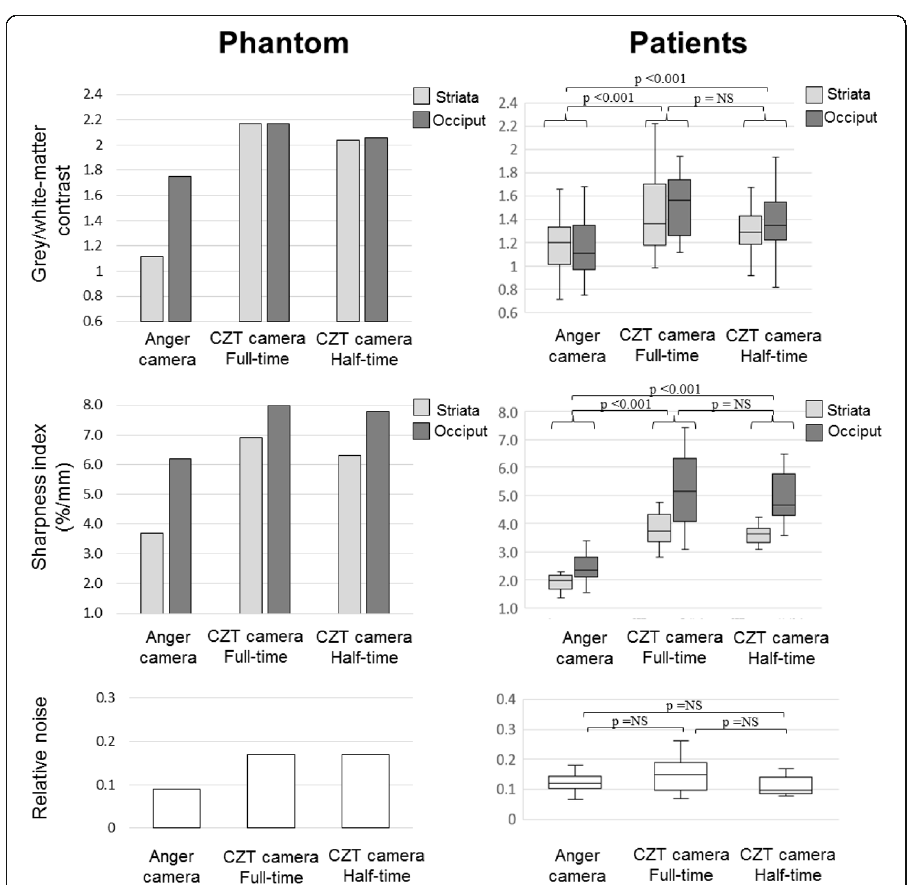
Fig. 2 Grey/white matter contrast (upper panel), spatial resolution assessed through a sharpness index (middle panel), and relative noise (lower panel), obtained for peripheral (occipital cortex, dark grey columns), central grey matter (striata, light grey columns), and white matter structures (semi-oval centers, white columns) on the SPECT images of phantom (left panel) and patients (box-plots, right panel) with conventional Anger camera (left columns) and with full-time (median columns) and half-time (right columns) recordings from the CZT camera. p values significant in clinical study are indicated on the